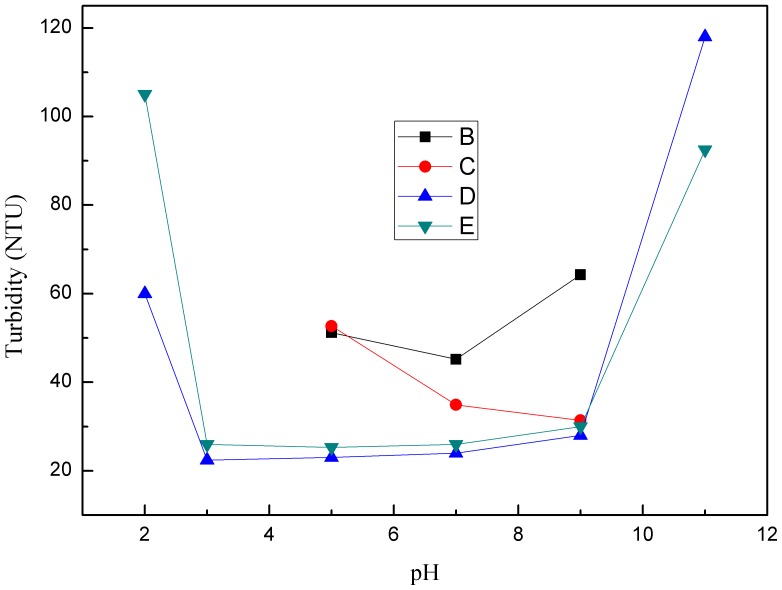
Effect of pH on supernatant turbidity.